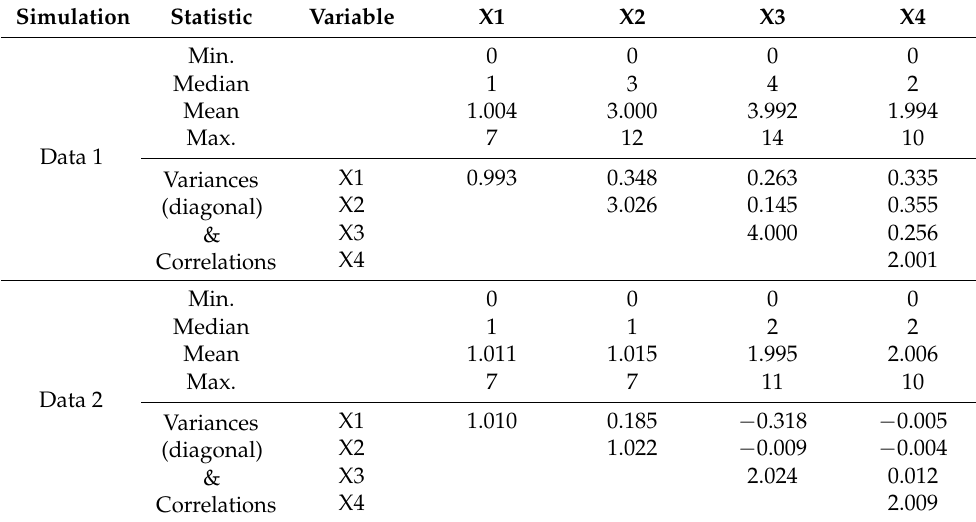
Table 4. Descriptive statistics of simulation data.